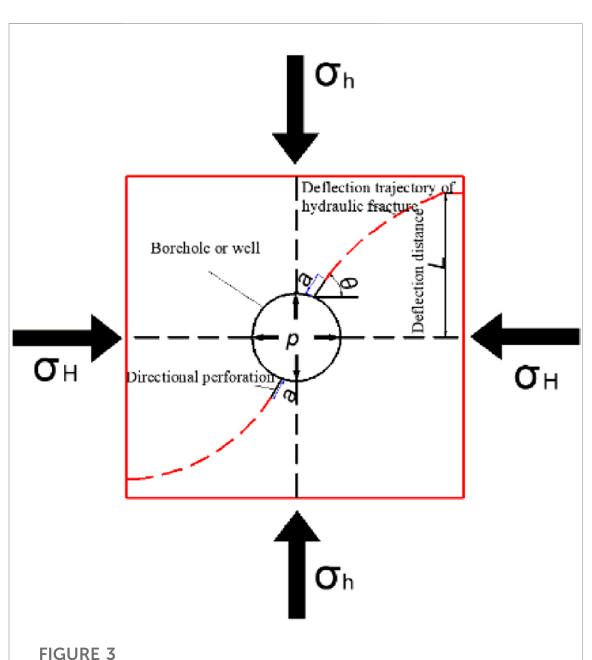
FIGURE 3 Evaluation indexes of spatial steering expansion of hydraulic